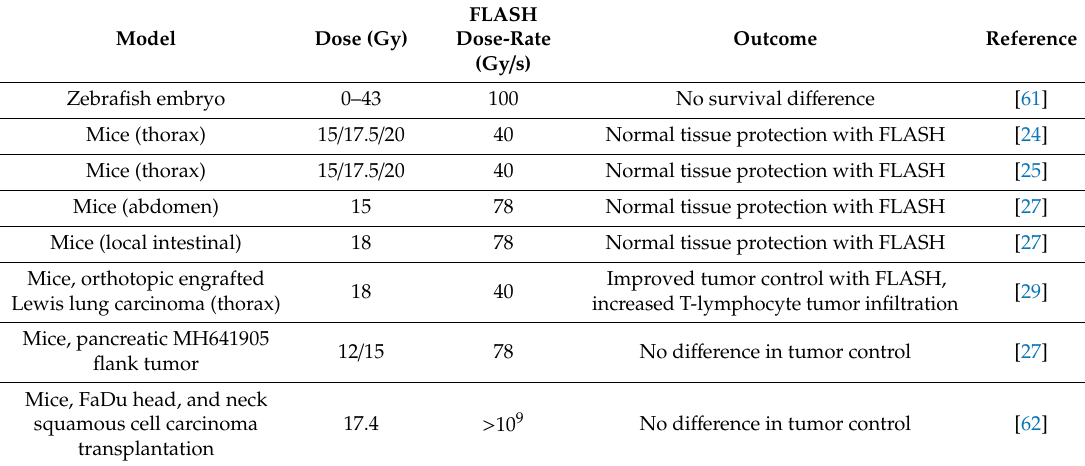
Table 3. Summary of outcomes in in vivo studies comparing FLASH and conventional dose-rate PBT.